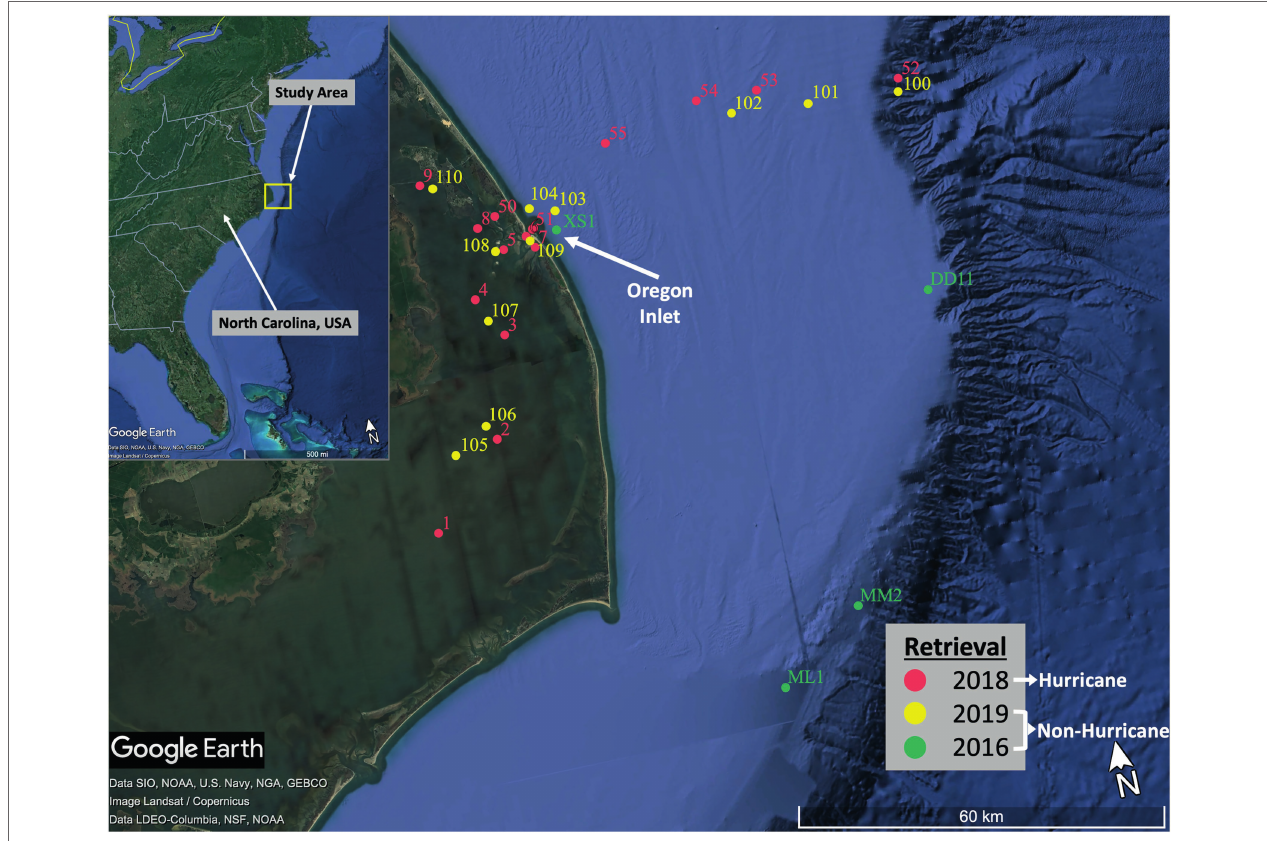
FIGURE 2 | Map of sampling sites from each retrieval. Sites represent both the northern (i.e., the Albemarle Sound) and southern region (i.e., the Pamlico Sound) of the Albemarle-Pamlico estuary, as well as within Oregon Inlet and along an E-W transect toward the edge of the continental shelf and Gulf